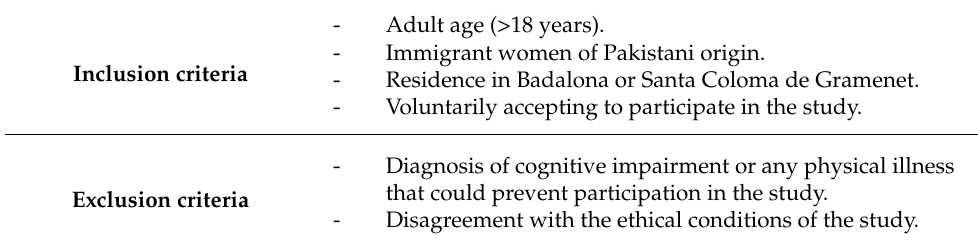
Table 1. Inclusion and exclusion criteria. - Adult age (>18 Inclusion criteria